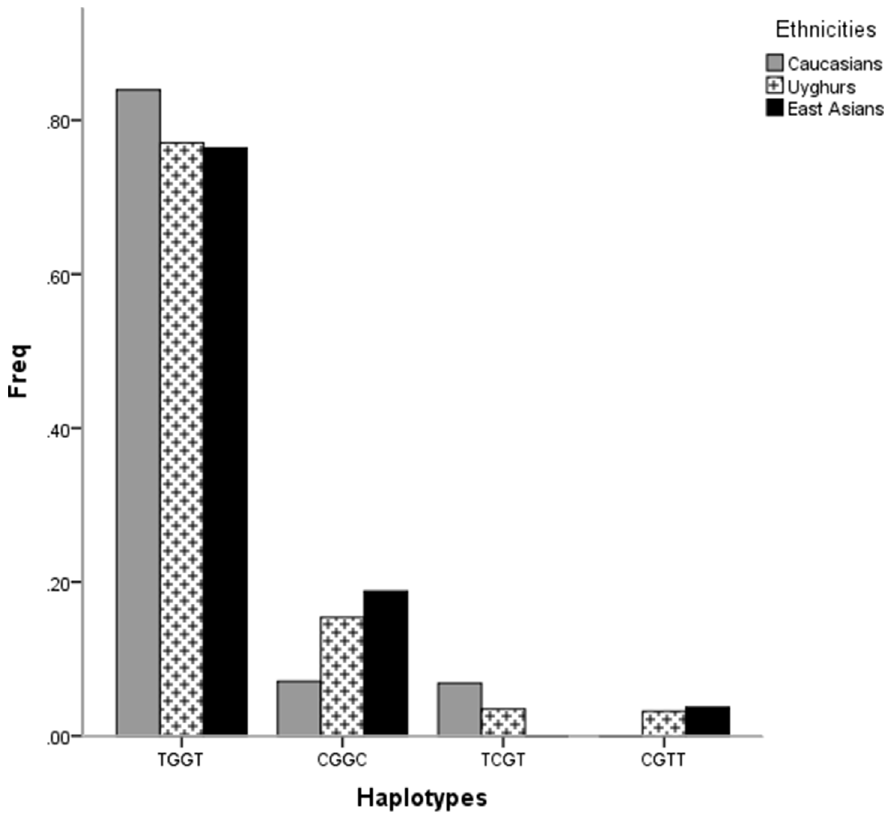
Figure 3. The frequencies of the haplotypes derived from the four SNPs in APOA5 in different populations. Based on the online databases and literatures in addition to our own data.